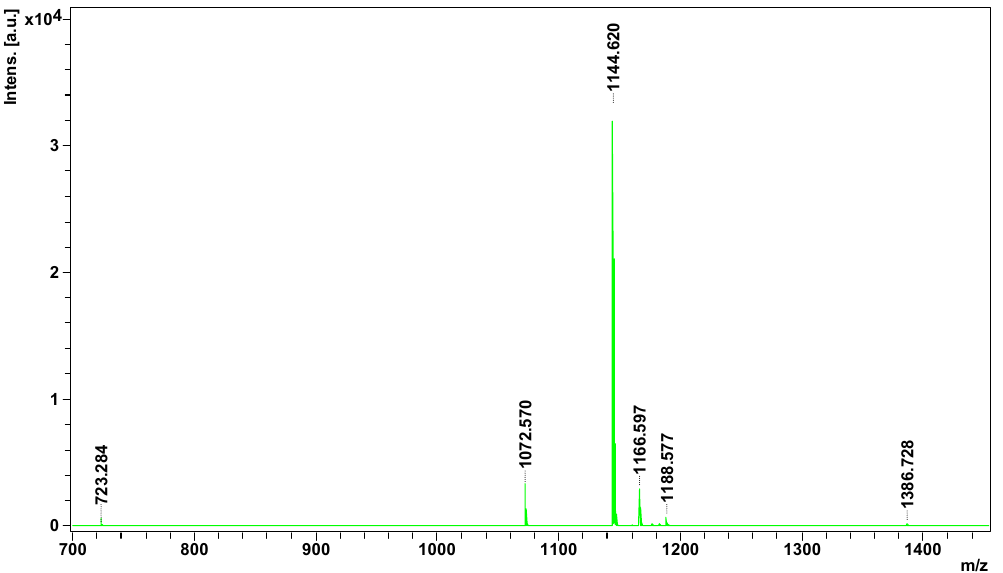
Figure 4. Mass spectrum of peptidome fraction of Vipera berus berus venom obtained on MALDI ToF/ToF mass spectrometer.